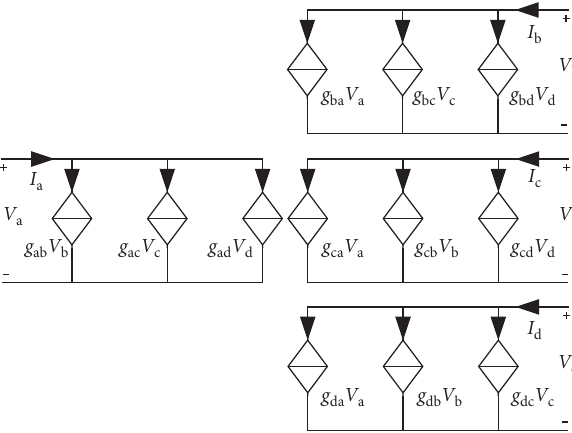
Figure 9: Average equivalent model of QP-M 2 DC